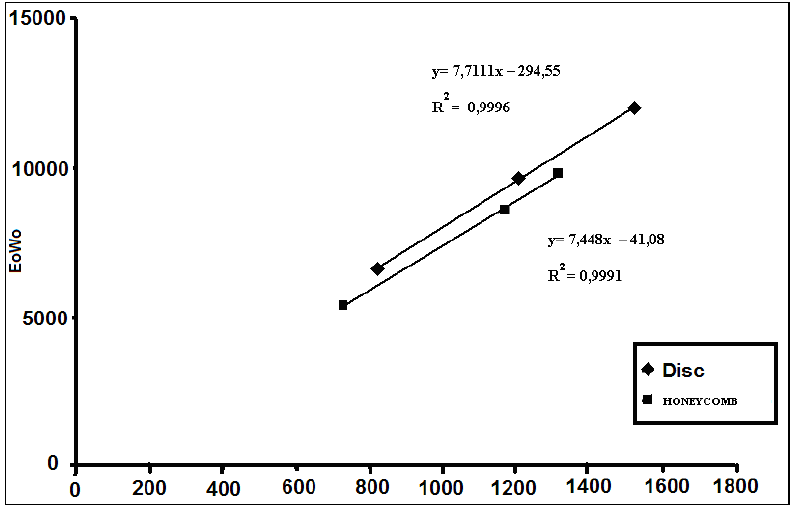
Figure 7. Product E the area